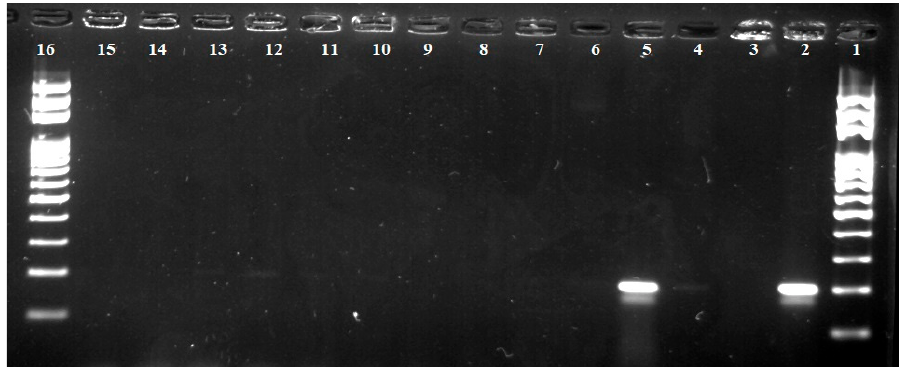
Figure 3. Detection of gluten in foods of plant origin (PCR product-200 bp). Lane 1—100 bp